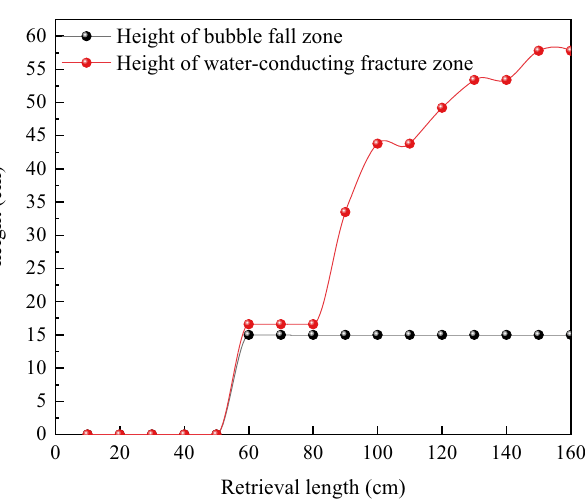
Figure 14. Relationship between propulsion distance and height of caving zone, fracture zone and water diversion fracture